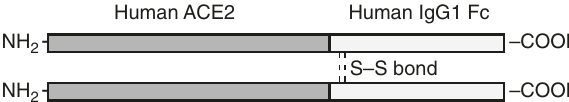
Fig. 1 Schematic of ACE2-Ig. The recombinant ACE2-Ig fusion protein exists as a homodimer with each subunit consisting of a ACE2 peptidase domain linked to an Fc domain of human